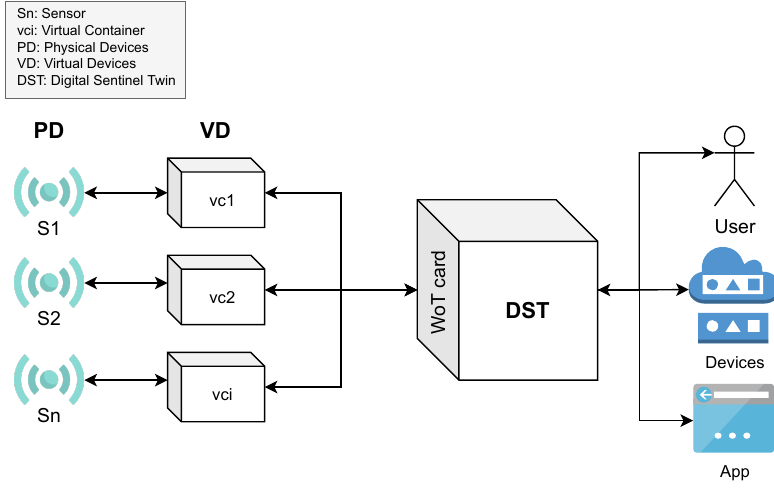
Figure 1. Conceptual view of a DST